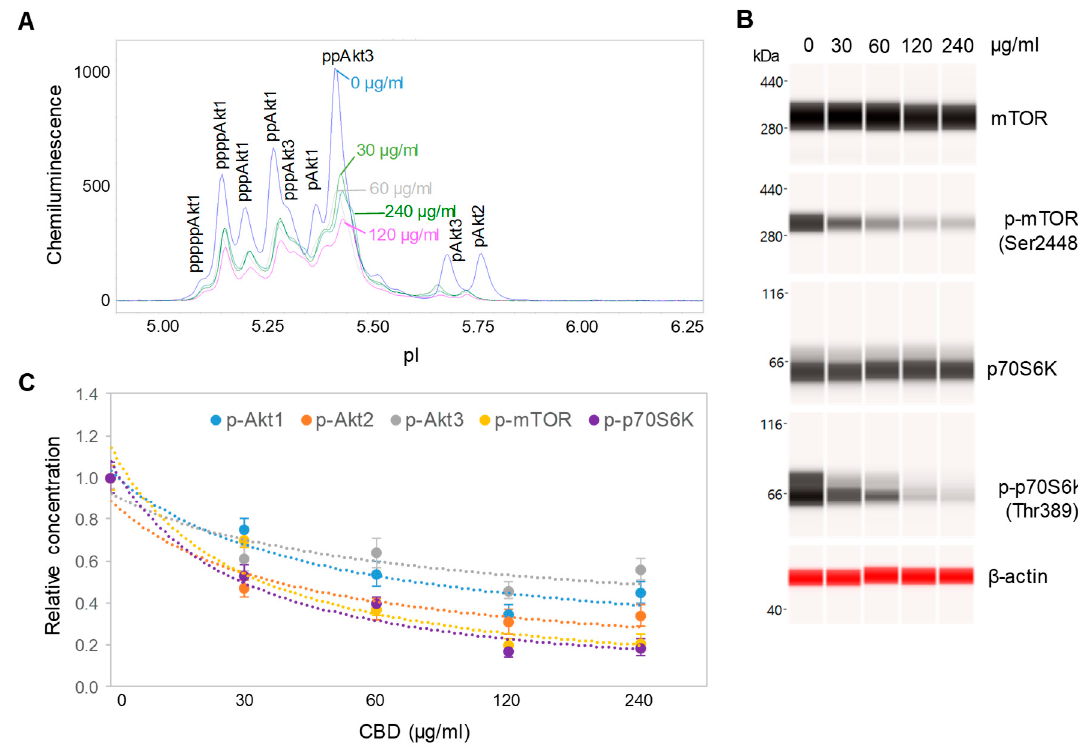
Figure 4. Dose-dependent negative regulation of the pI3K / Akt / mTOR signaling pathway by a CBD oil. ( A ) The pan-Akt profiles of SH-SY5Y cells as a function of CBD oil V1 dosages; ( B ) the expression levels of mTOR and p70S6K phosphoisoforms as a function of CBD oil V1 dosages; ( C ) the relative concentrations of Akt, mTOR, and p70S6K phosphoisoforms as a function of CBD oil V1 dosages. Relative concentration describes fold change of protein phosphoisoforms after treatment as compared with the control. Error bars are the standard deviations of six repeated measurements per experimental condition. SH-SY5Y cells were treated with various dosages of CBD oil V1 for 24 h.